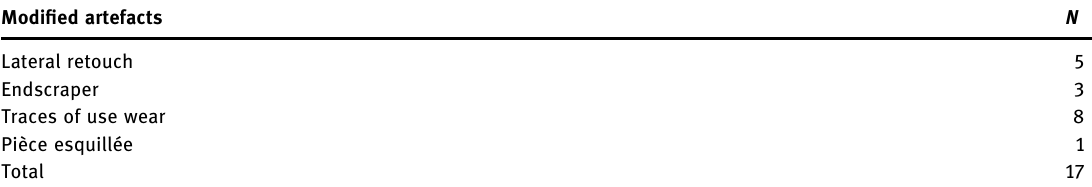
Table 9: Tool classes Bäramähder. Modi fi ed artefacts Lateral